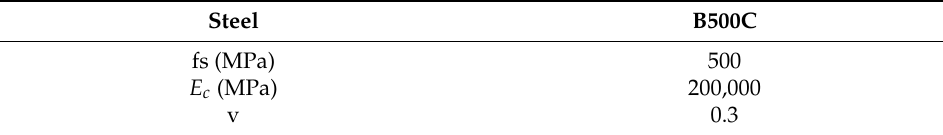
Table 2. Material properties of steel.